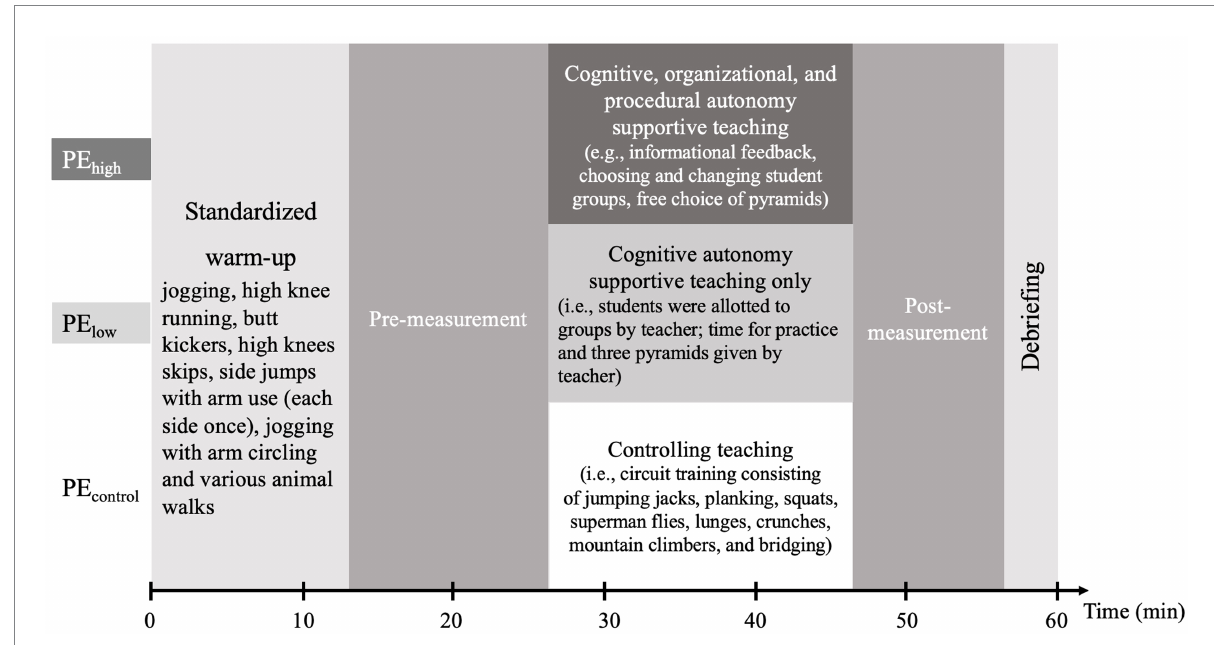
FIGURE 1 Experimental procedure; PE high , high autonomy-supportive PE teaching; PE low , low autonomy-supportive PE teaching; PE control , controlling PE